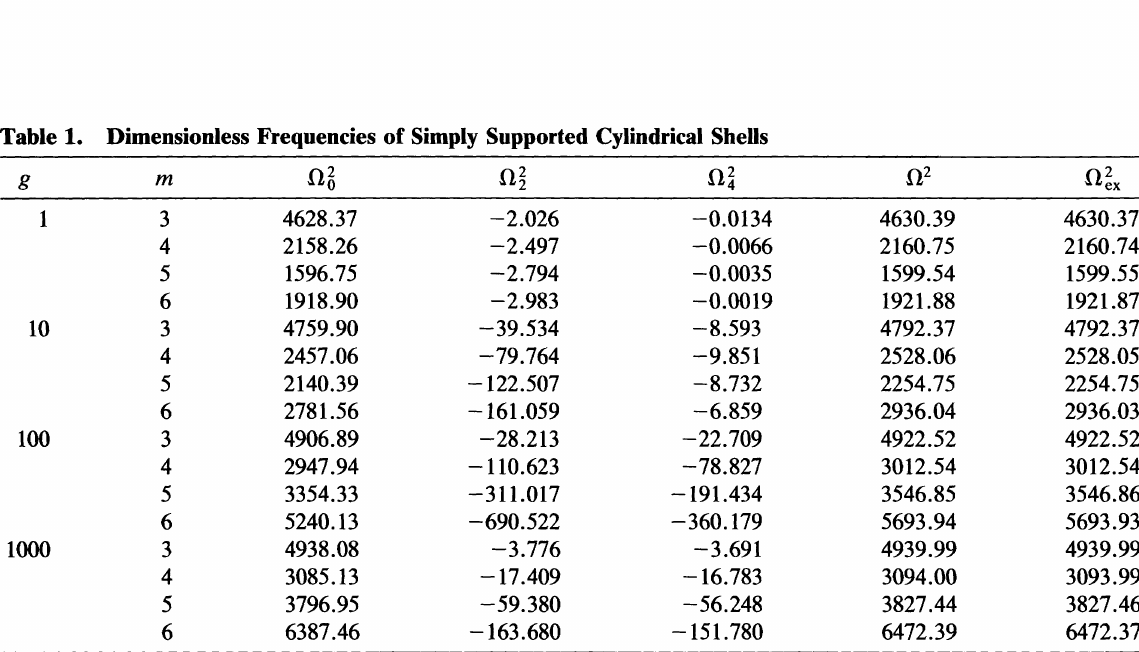
FIGURE 3 Ratio of 'Y/* to f3 vs. the variable g (m = 4 and 5) for simply supported